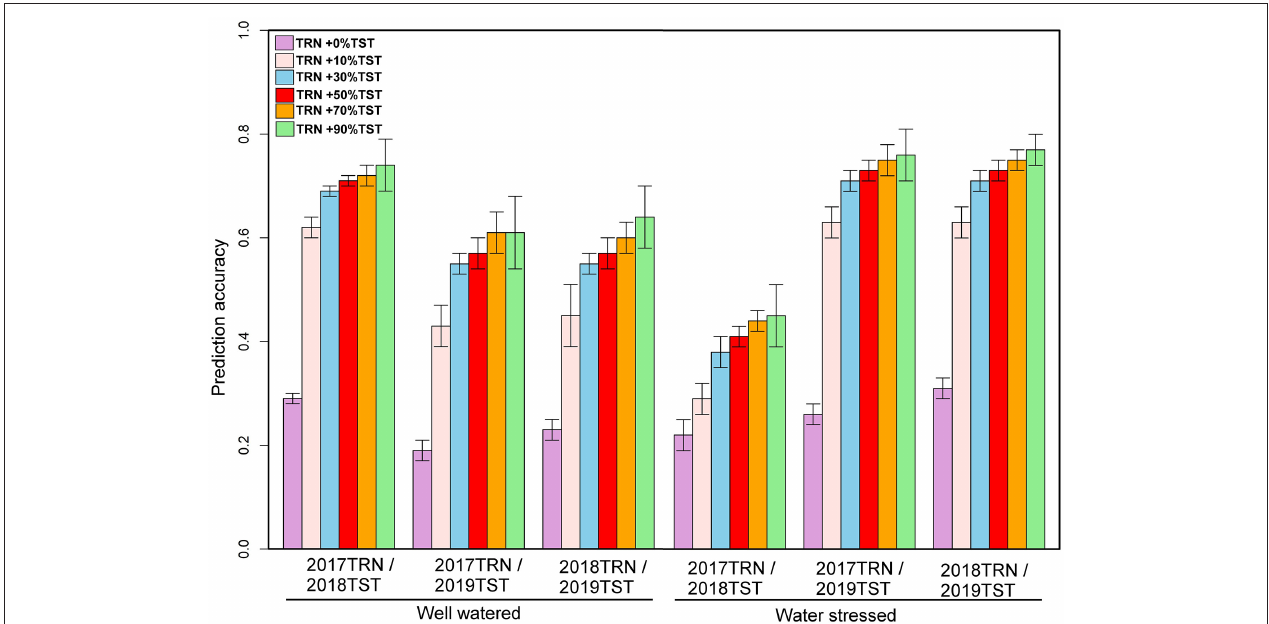
FIGURE 2 | Prediction accuracies for GY estimated using 1-year data to predict another year’s data and converting 10, 30, 50, 70, and 90% of the data from the testing population to the training population under WW and WS conditions. GY, grain yield; WW, well-watered; WS,